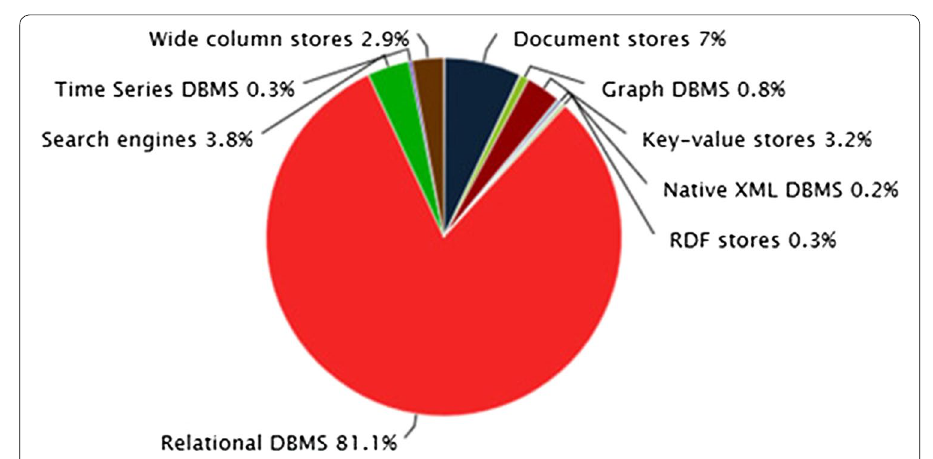
Fig. 1 Ranking scores per data model in percentage